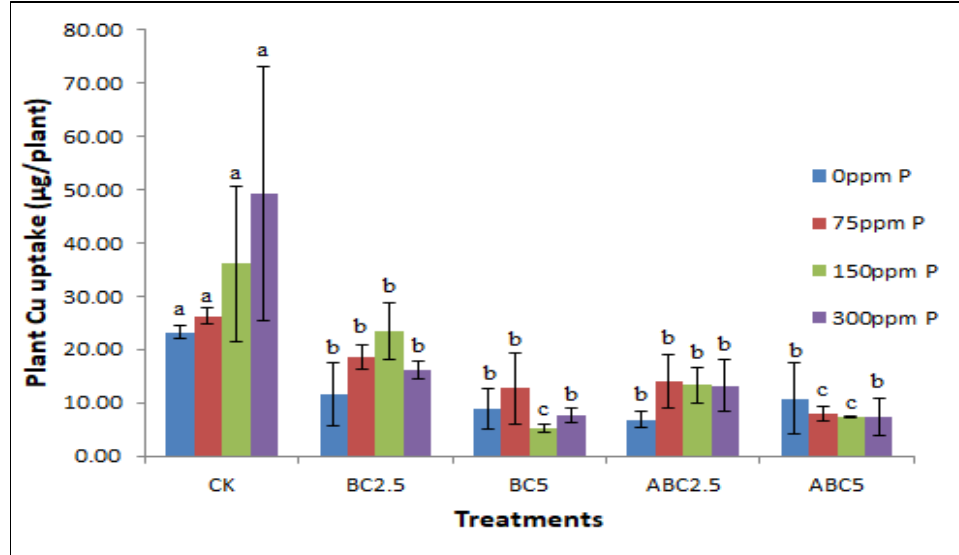
Figure 10. Effects of BC and ABC applied at different rates with different P fertilizer application rates on Plant Cu uptake ( μ g/plant). Means with different letters within each fertilizer rate across each treatment indicate significant differences according to the least significant difference (LSD) test at p < 0.05. CK = Control, BC2.5 = Biochar added at 2.5% w / w , BC5 = Biochar added at 5% w / w , ABC2.5 = Acidified biochar added at 2.5% w / w , and ABC5 = Acidified biochar added at 5% w / w .